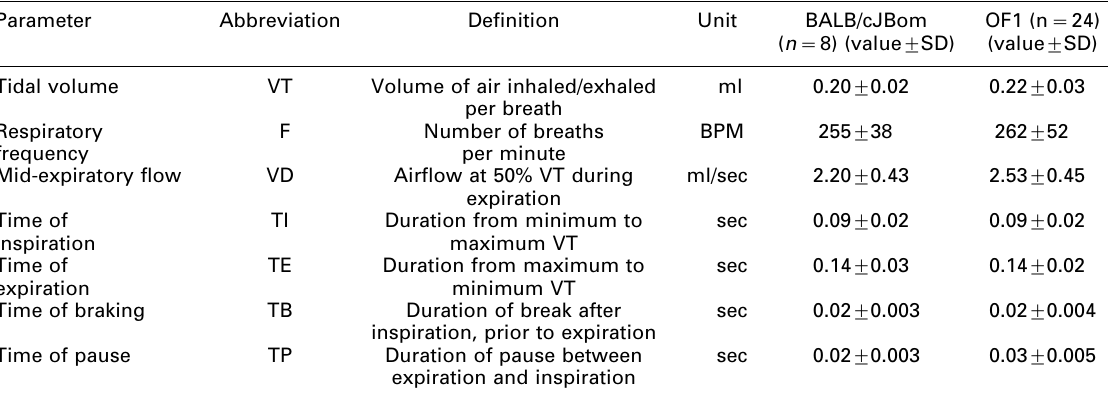
Table 2. Respiratory parameters calculated from airflow signals Parameter